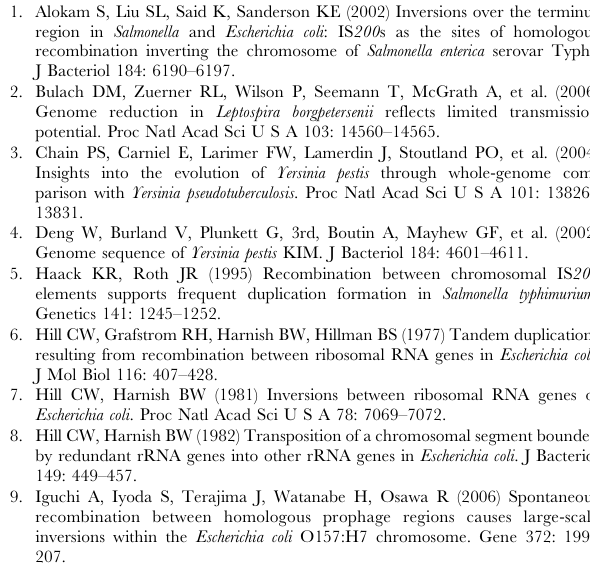
Table S1 Estimated Replichore Length and Balance of Natural Arrangement Types.